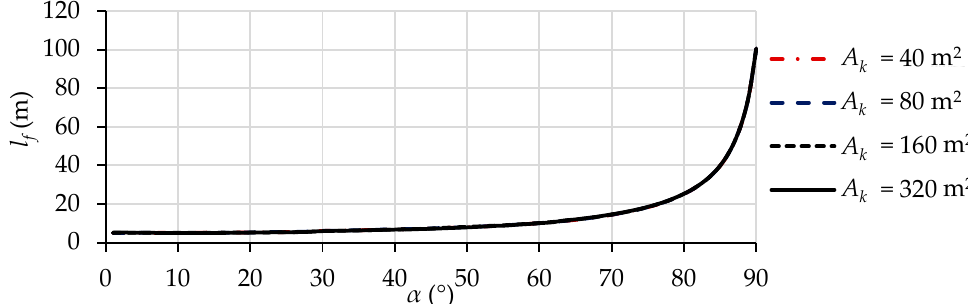
Figure 11. The front bridle line lengths for each kite area and angle of attack at a ship speed of 7.27 m/s and a reference wind speed of 20 m/s.